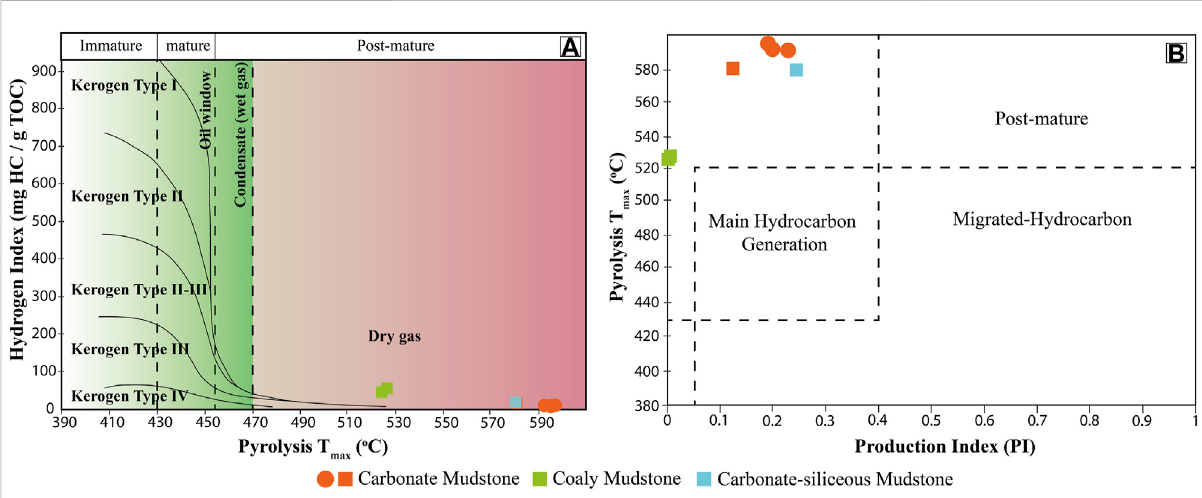
FIGURE 8 (A) Cross-plot of the hydrogen index and Tmax showing the type of kerogen and thermal maturity of the studied samples. (B) Cross-plot of Tmaxandproductionindex(PI)showingthematurationofthestudiedsamples.Theredrectangle, greenrectangle,andbluerectanglerepresentthe samples from location A, while the red dot denotes the samples from location